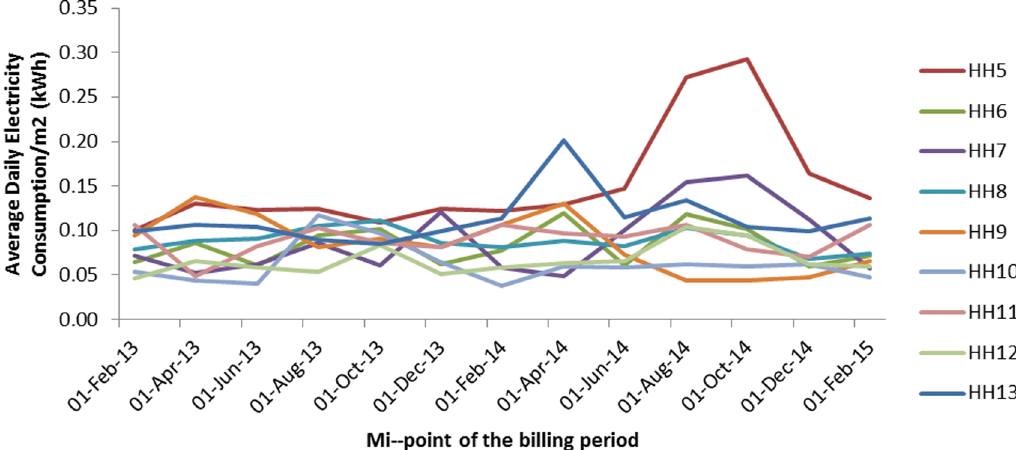
Fig. 4. Average daily electricity consumption (kWh) by extreme electricity users.